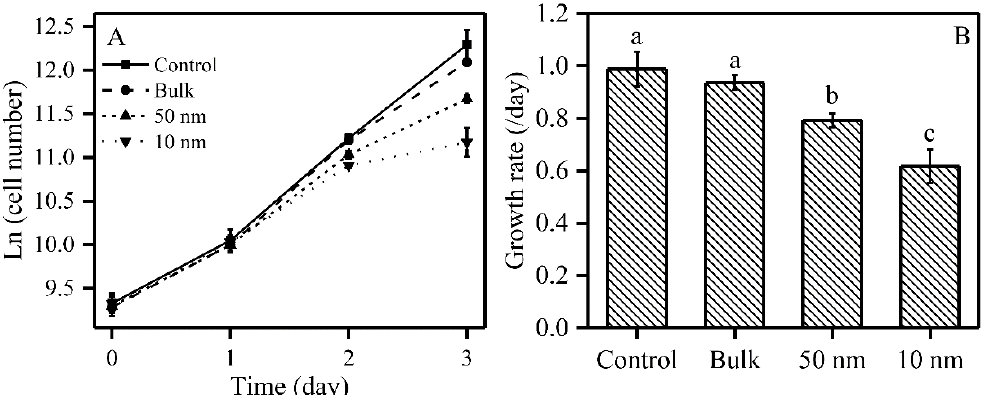
Figure 1. Effects of three sizes of TiO 2 particles on the growth of S. obliquus . Panel ( A ): Growth curves; Panel ( B ): Growth rate; Different letters on the error bars represent significant (Tukey’s honestly significant difference (HSD), p < 0.05) differences. Values are represented as means ± SD ( n = 6).